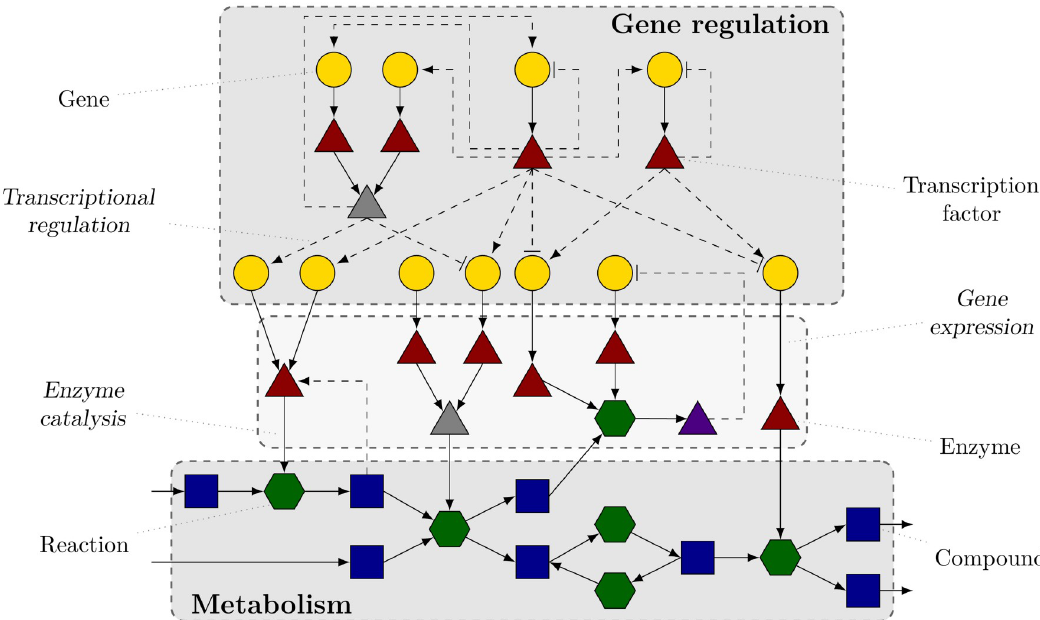
Fig 1. Schematic representation of the involved processes and biological elements in the integrative metabolic-regulatory E. coli network. Gene regulatory processes primarily comprise genes (yellow circles) and several proteins (monomers (brown triangles) as well as complexes (gray triangles)), mainly transcription factors. In contrast, metabolic processes are predominantly defined by small molecules (blue squares) and the catalyzing biochemical reactions (green hexagons). The interactions between regulatory and metabolic processes can be mainly characterized by proteins (also modified proteins (purple triangles)) serving as enzymes and regulators, respectively. The symbols are also explained in Fig 2. While regulatory links are represented as dashed lines, the encoding and reaction-associated links are shown as solid lines. Note that this scheme does not cover all aspects of the biological categories and their classification (see Methods for